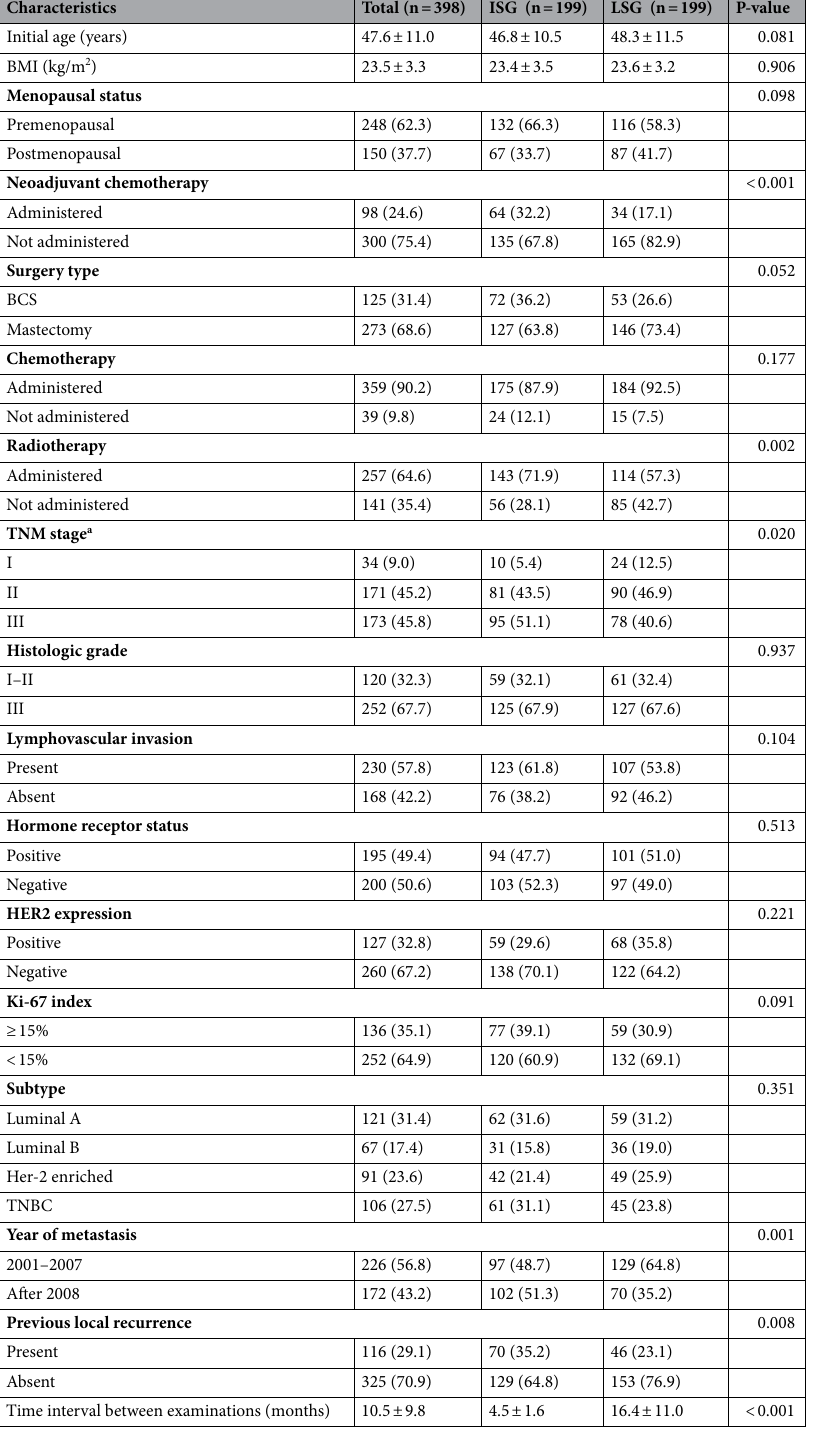
Table 1. Demographic and clinical characteristics of patients. Data are number of patients and percent (%) or mean ± standard deviation. ISG intensive surveillance group, LSG less-intensive surveillance group, BMI body mass index, BCS breast-conserving surgery, HER2 human epidermal growth factor receptor 2, TNBC triple- negative breast cancer. a Stratified according to the American Joint Committee on Cancer (AJCC) 7 th TNM